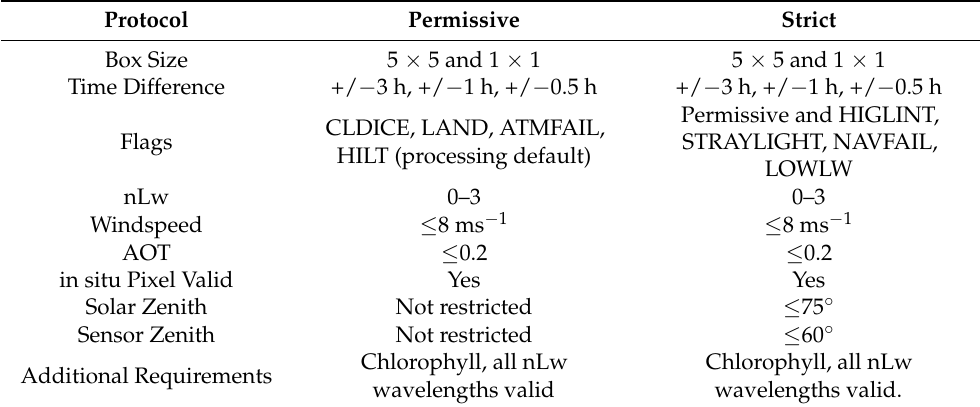
Table 1. Exclusion criteria for the permissive and strict